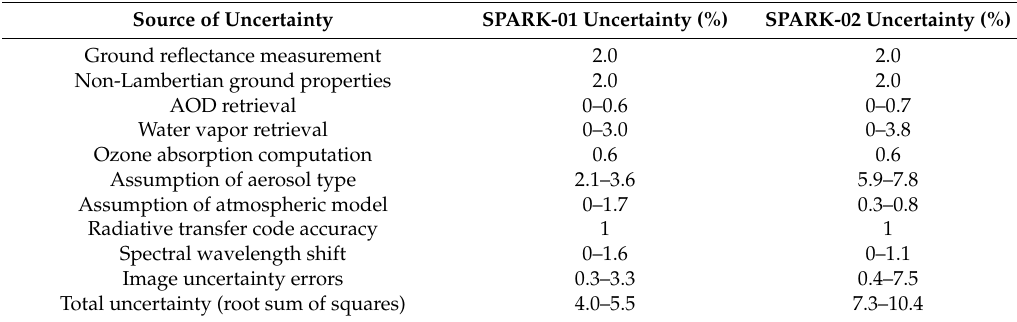
Table 5. Estimated uncertainty associated with the reflectance-based method.